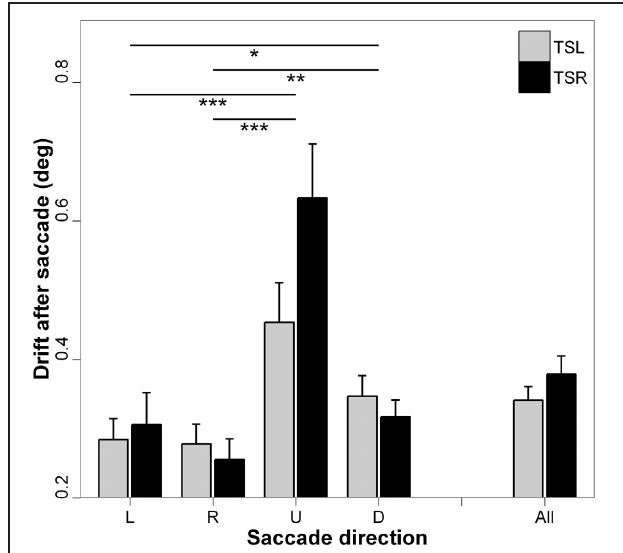
FIGURE 4 | Mean values of amplitude for each saccade direction (L, leftward; R, rightward; U, upward; D, downward) and tinnitus side (TSL, tinnitus side left; TSR, tinnitus side right). The dashed line represents the target amplitude. Error bars represent the standard error. The symbol ∗ indicates a statistically significant effect ( ∗ p < 0 . 05; ∗∗ p < 0 . 01; ∗∗∗ p < 0 . 001).